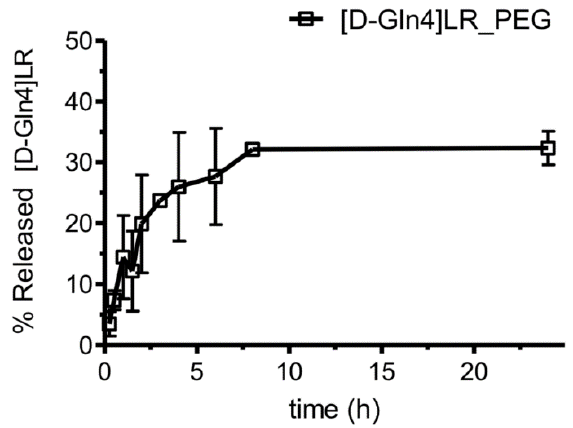
Figure 7. Time course of the [D-Gln4]LR release percentage from [D-Gln4]LR-PEGylated liposomes in phosphate buffer saline (PBS; pH 7.4). Error bars, SD; where not visible, error bars did not exceed symbol size.